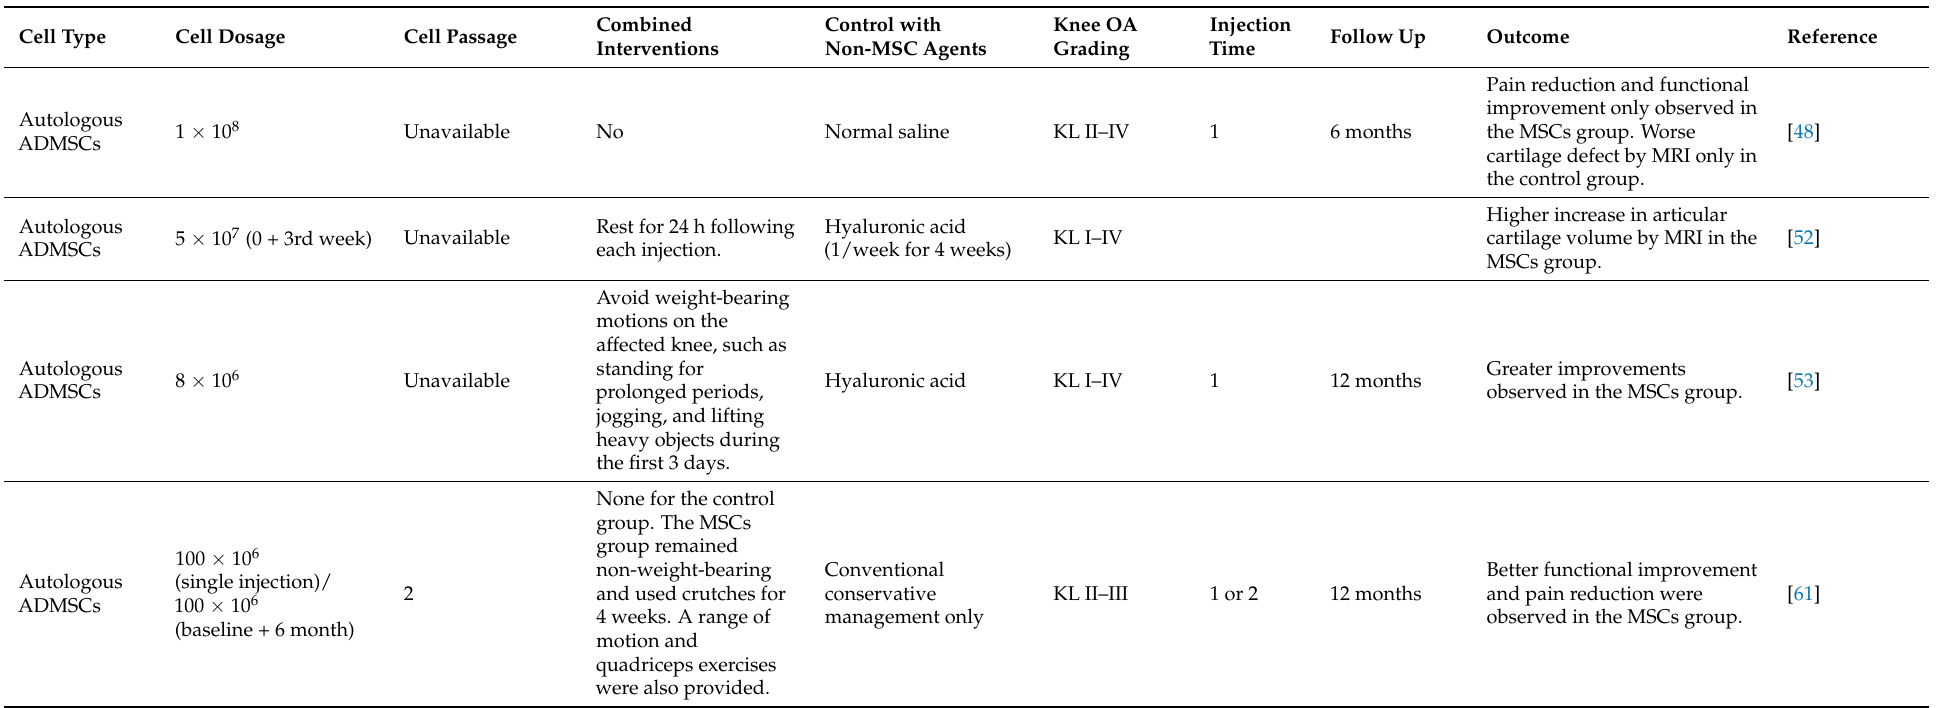
Table 3. Substance comparison injection studies using autologous adipose-derived